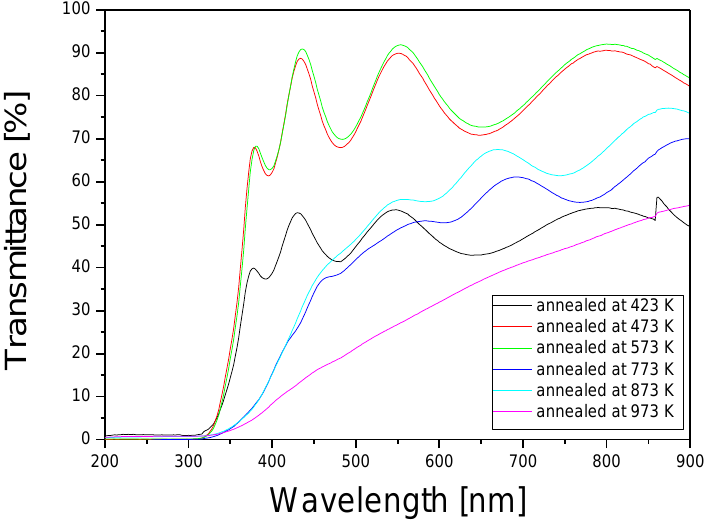
Figure 6. Transmittance measurements of the TO films annealed in the range of temperatures from 423 K to 973